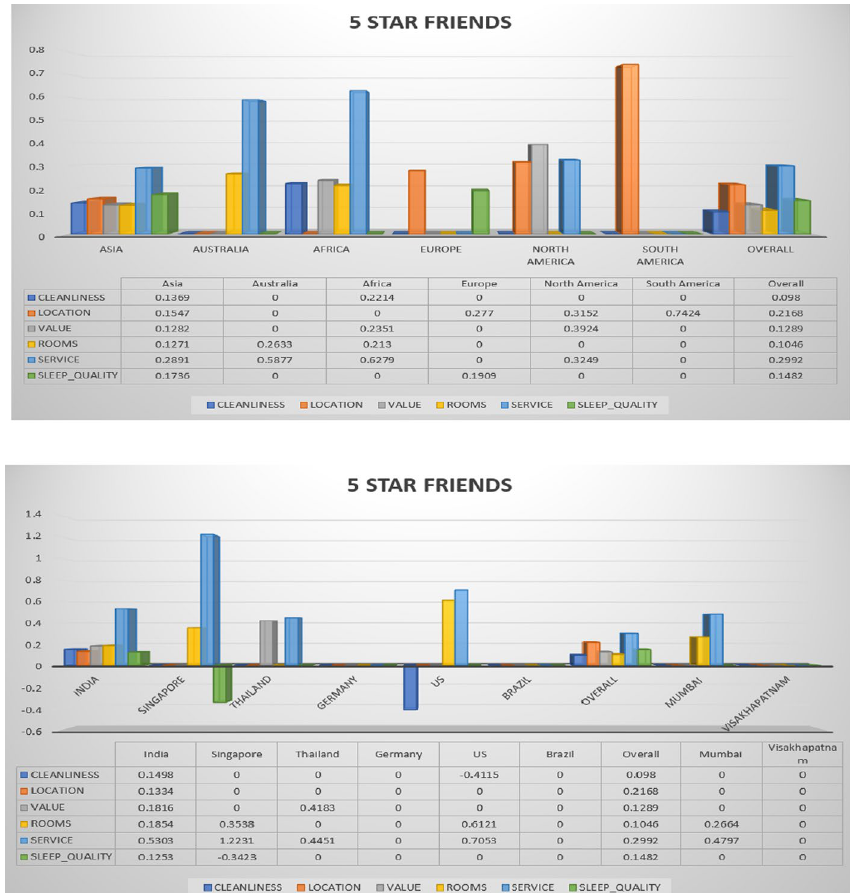
Fig. 4 Hotel class: 5 star, Trip Type: Travelled with friends (continent, country and